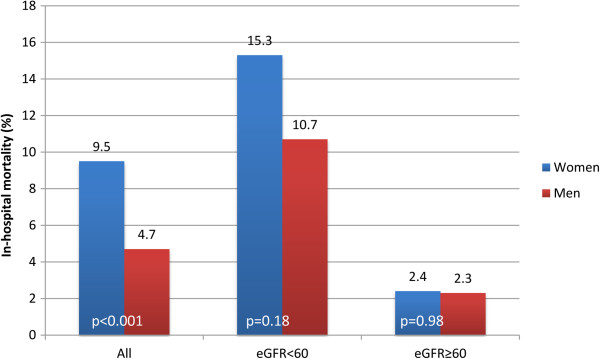
In-hospital mortality according to gender and renal function. eGFR = estimated glomerular filtration rate. Blue bars = women. Red bars = men.